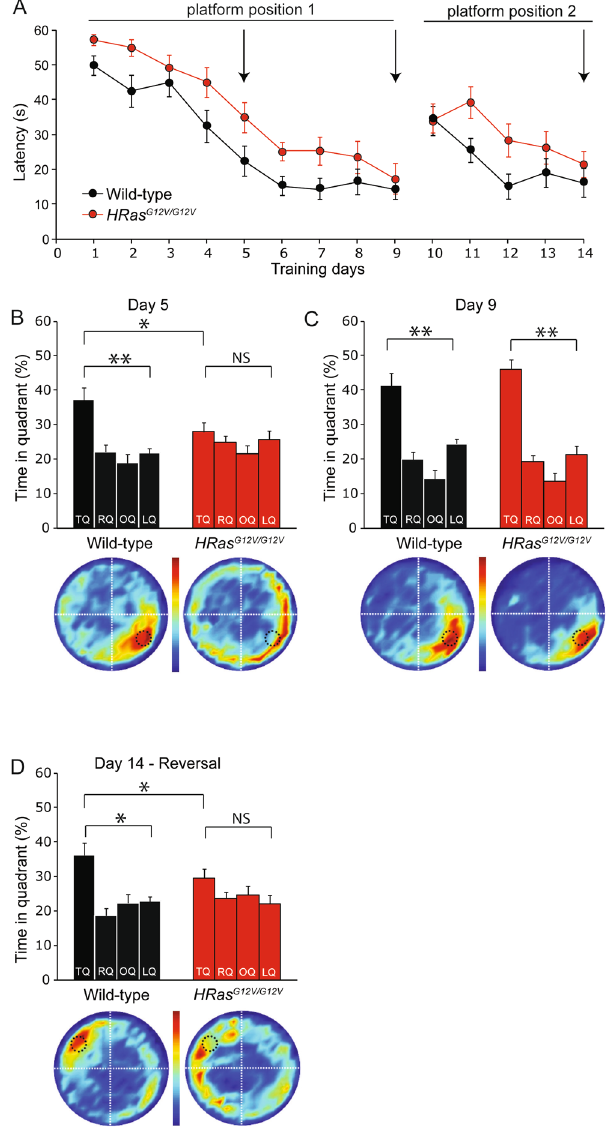
Figure 3. Learning impairment in HRas G12V/G12V mice in the Morris water maze (MWM). ( A ) Average latency to find the platform for each day of training. The first 9 days represent hidden platform MWM training for the initial platform position (platform position 1). On day 10, the reversal MWM protocol was started by changing the platform position (platform position 2). A decrease in the latencies of both genotypes can be observed, however on average HRas G12V/G12V mice took significantly more time to find the platform (between subject comparison day 1–9: F 1,30 = 12.78, P < 0.01; day 10–14: F 1,15 = 6.53, P < 0.05 . ( B ) When spatial memory was assessed in a probe trial after 5 days of training, wild-type mice preferentially searched in the target quadrant (TQ, black bar) where the submerged platform had been during the training sessions (TQ vs. other quadrants: P < 0.01), whereas HRas G12V/G12V mice did not show a preference for the target quadrant (P = 0.15); between subject comparison: effect of genotype, P < 0.05). TQ = target quadrant, RQ = adjacent right quadrant, LQ = adjacent left quadrant, OQ = opposite quadrant. ( C ) A probe trial after four additional days of training showed that HRas G12V/G12V mice catch up with their WT littermates (TQ vs. other quadrants: HRas G12V/G12V : P < 0.01, WT: P < 0.01; between subject comparison: effect of genotype P = 0.79). Heat plots beneath the graphs provide a visual representation of all search tracks, in which the color indicates the mean time spent at a certain position in the pool. ( D ) After hidden-platform training mice were re-trained in a reversal MWM task. After 5 days of training for a new platform position (day 10–14; platform position 2), wild-type mice but not HRas G12V/ G12V animals showed a preference for the TQ (TQ vs. other quadrants wild-type : P < 0.01; TQ vs. OQ HRas G12V/ G12V : P = 0.14; between subject comparison: effect of genotype P = 0.17). Data are presented as mean ± SEM from wild-type n = 17 mice, HRas G12V/G12V n = 15 mice (for A,B ) and from wild-type n = 10 mice, HRas G12V/G12V n = 8 mice (for C ). Statistical test: repeated measure one-way MANOVA, paired two-tailed t -test and one-way MANOVA. Arrows in A indicate day of probe